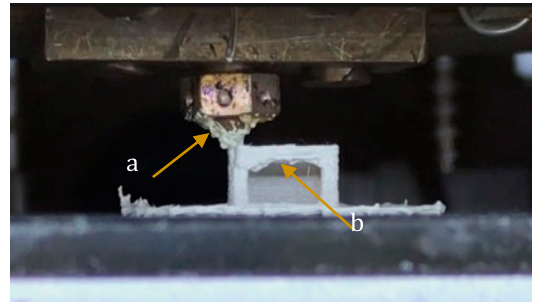
Figure 4. A shot of the 3D printer in the processing of DC4430 PEEK. ( a ) The residual material sticking to the nozzle. ( b ) The structure defect of sample.